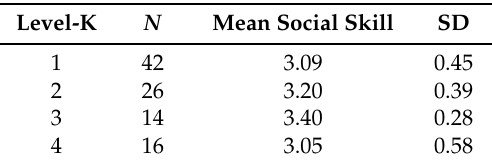
Table 4. Mean social skill for each level-K group (L > 0).